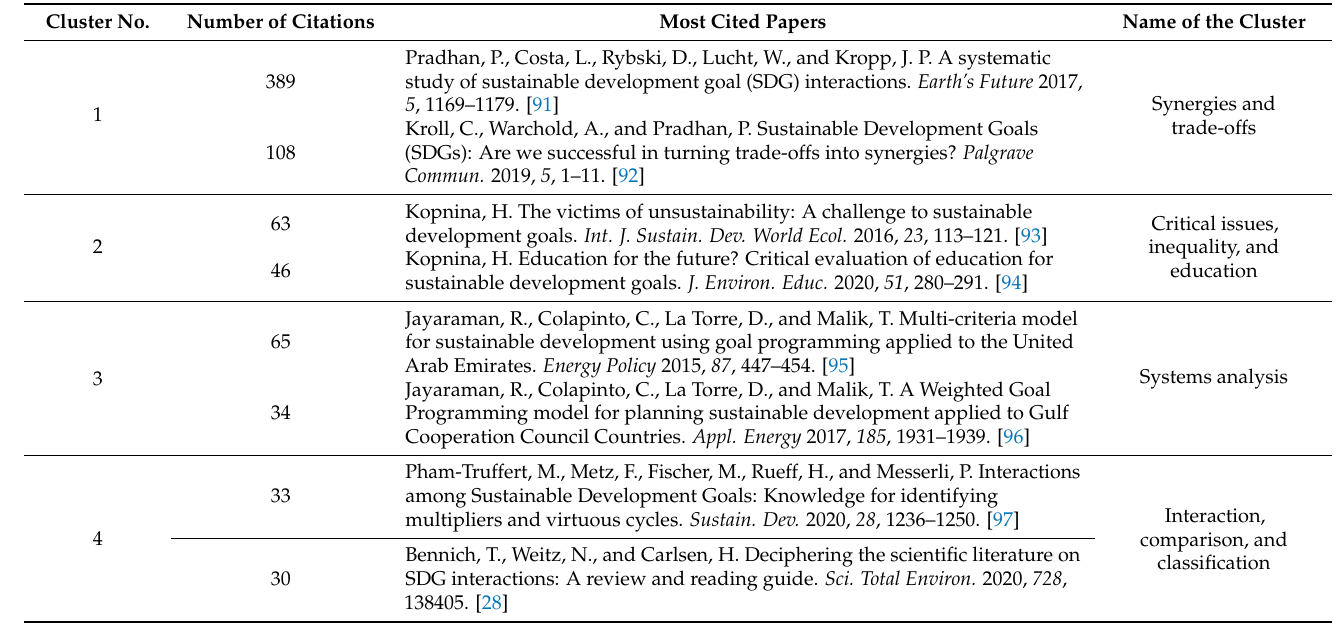
Table 8. The 11 clusters derived by CATAR and the corresponding numbers and percentages of papers and the characteristic